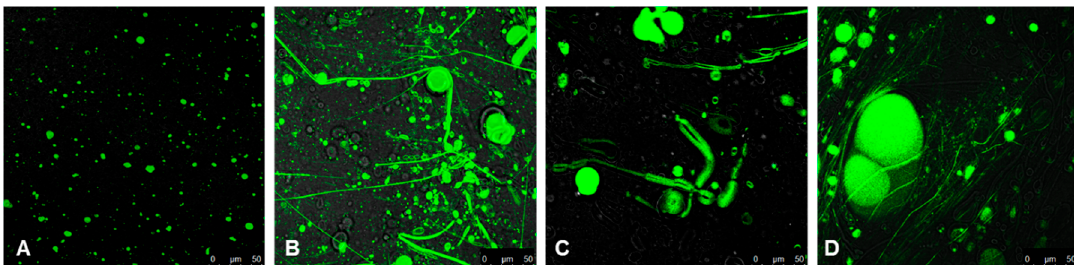
Figure 7. Confocal microscopy images of DOPC / DOPG 90:10 M / M labelled MLVs ( A ) and DOPC / DOPG 90:10 M / M labeled MLVs in the presence of 737-786 gp36 CHR–MPER ( B – D ). In B–D, the same sample is imaged in di ff erent regions of the field. DOPC phospholipids include 2.25 mM NBD-PC. Images were acquired on a laser scanning confocal microscope (LSM 510; Carl Zeiss Micro-Imaging) equipped with a plan Apo 63 × , NA 1.4 oil immersion objective lens. For each field, both fluorescent and transmitted light images were acquired on separate photomultipliers and were analysed using Zeiss LSM 510